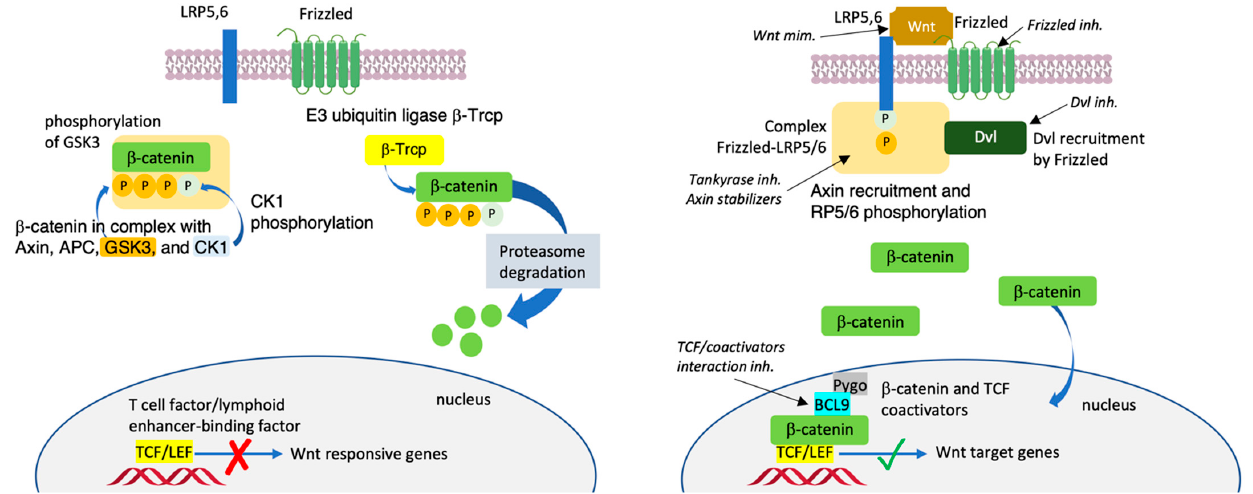
Figure 1. Sketch of the canonical Wnt/ β -catenin signaling pathway without a Wnt ligand (left panel) and upon binding with a Wnt ligand (right panel). Molecules being evaluated in clinical studies: Wnt ligand mimetics, inhibitors of Frizzled, Dvl, Tankyrase, TCF/coactivators interactions or Axyn stabilizers.